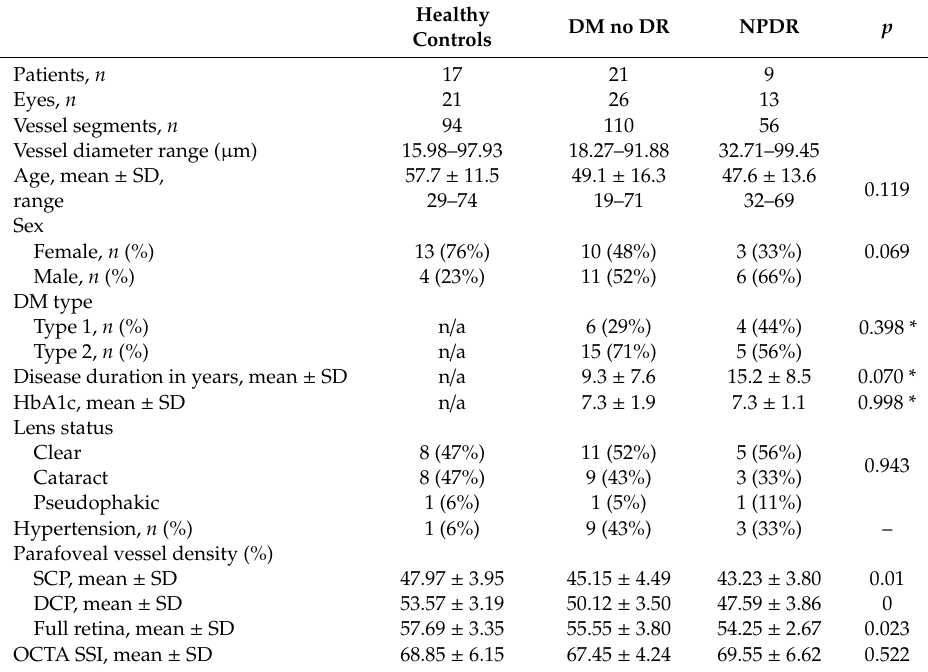
Table 1. Patient demographics, clinical and diabetes characteristics, and capillary measurements on optical coherence tomography